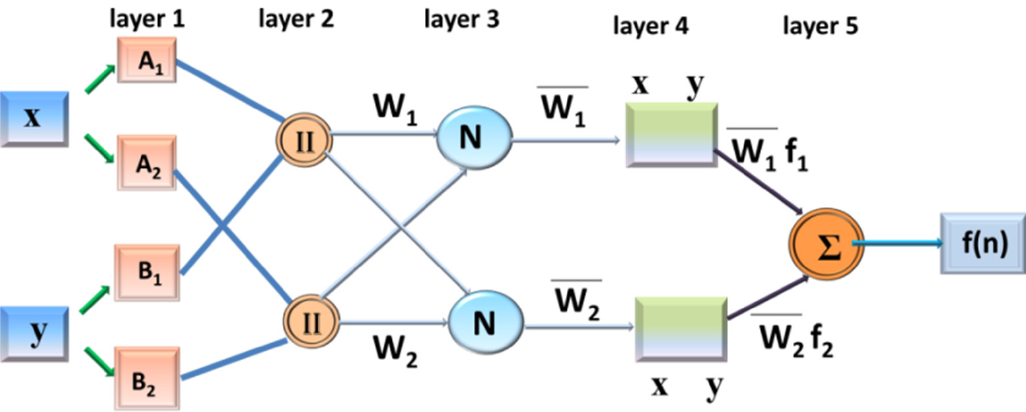
Figure 5. Structural representation of ANFIS.